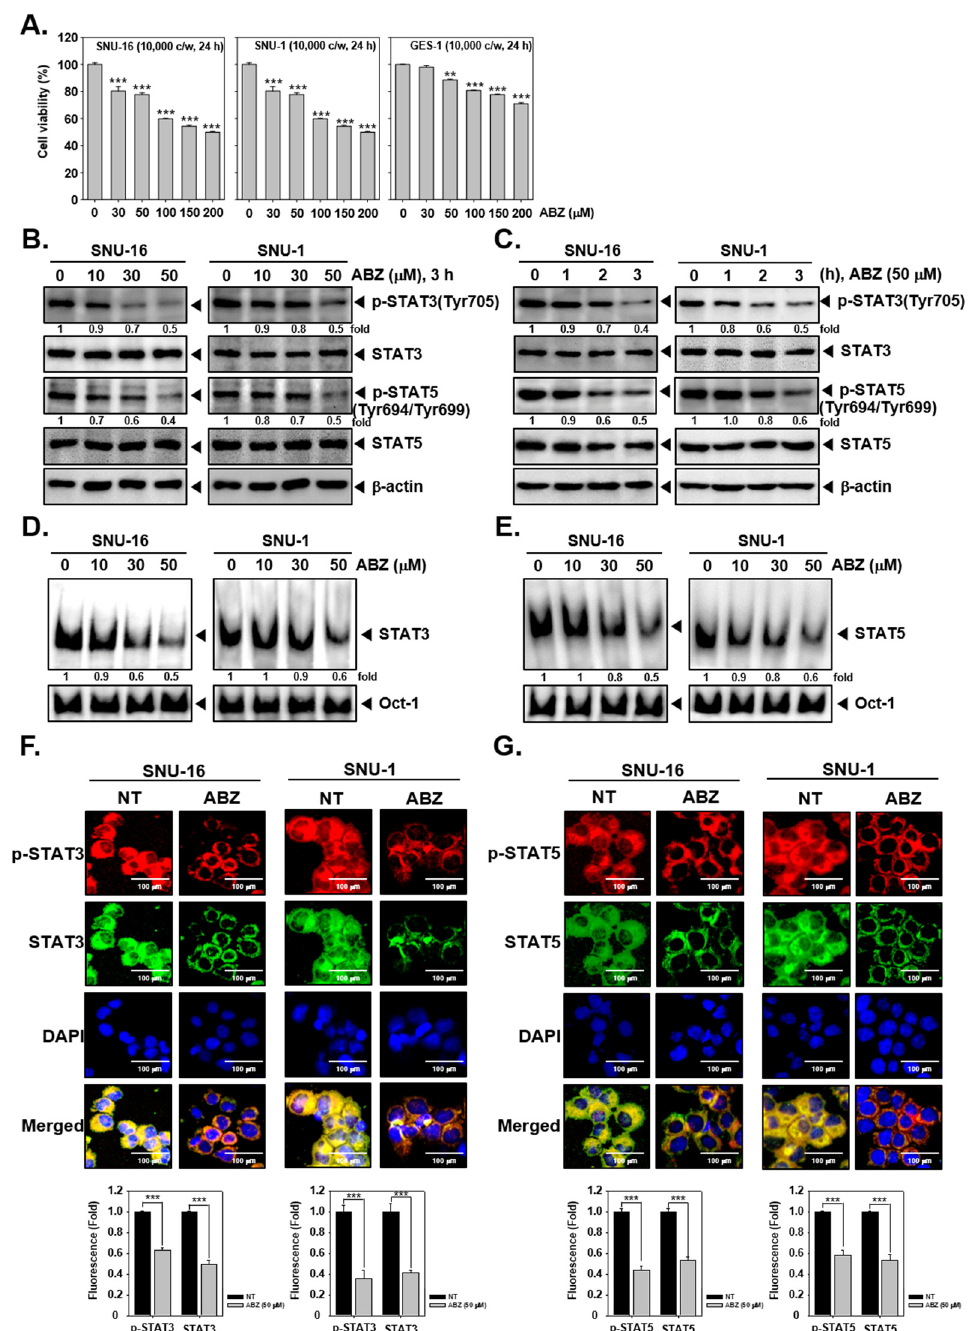
Figure 2. ABZ affects STAT3/5 phosphorylation. ( A ) SNU-16, SNU-1, and GES-1 cells were treated with ABZ (0, 10, 30, 50, 100 µM) for 24 h, then viability deciphered by MTT assay. ( B ) SNU-16 and SNU-1 cells (1 × 10 6 cells/well) were treated with ABZ (0, 10, 30, 50 µM) for 3 h and western blotting was done. ( C ) Cells were treated with 50 µM of ABZ for (0, 1, 2, 3 h) and western blotting was carried out ( D , E ) SNU-16 and SNU-1 cells were treated as described above in panel C and nuclear STAT3 and STAT3 levels were determined. ( F , G ) The cells were treated with 50 µ M of ABZ for 3 h and intracellular p-STAT3 and p-STAT5 distribution was evaluated by immunocytochemistry. Data represent means ± SD. ** p < 0.01 vs. non-treated (NT) cells, *** p < 0.001 vs. non-treated (NT) cells. The results shown are representative of three independent